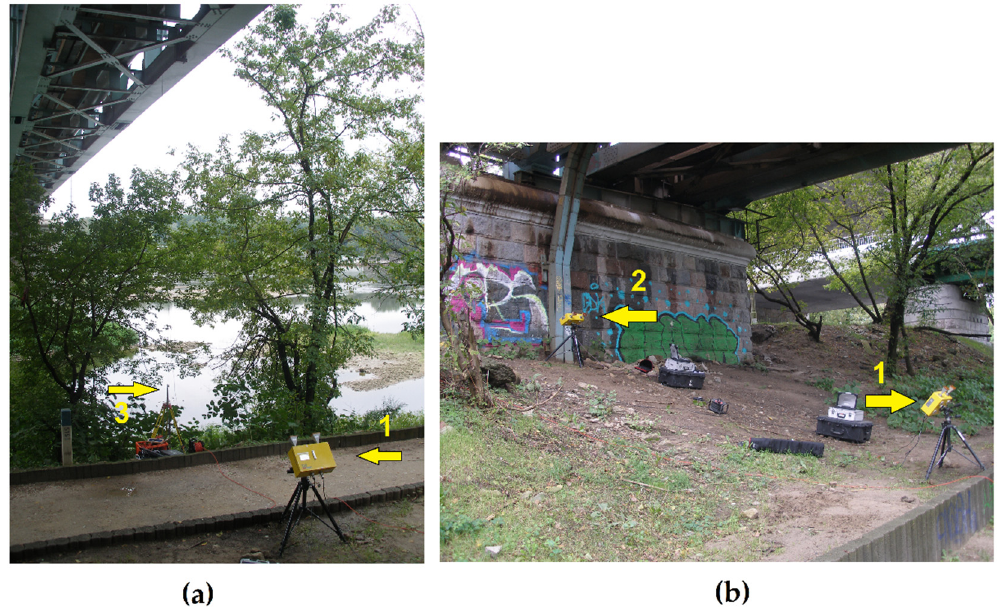
Figure 9. Bridge No. 1—test at cross-section No. 1: ( a ) 1—radar No. 1, 3—inductive transducer for the reference measurement; ( b ) 1 and 2—radar No. 1 and No. 2.